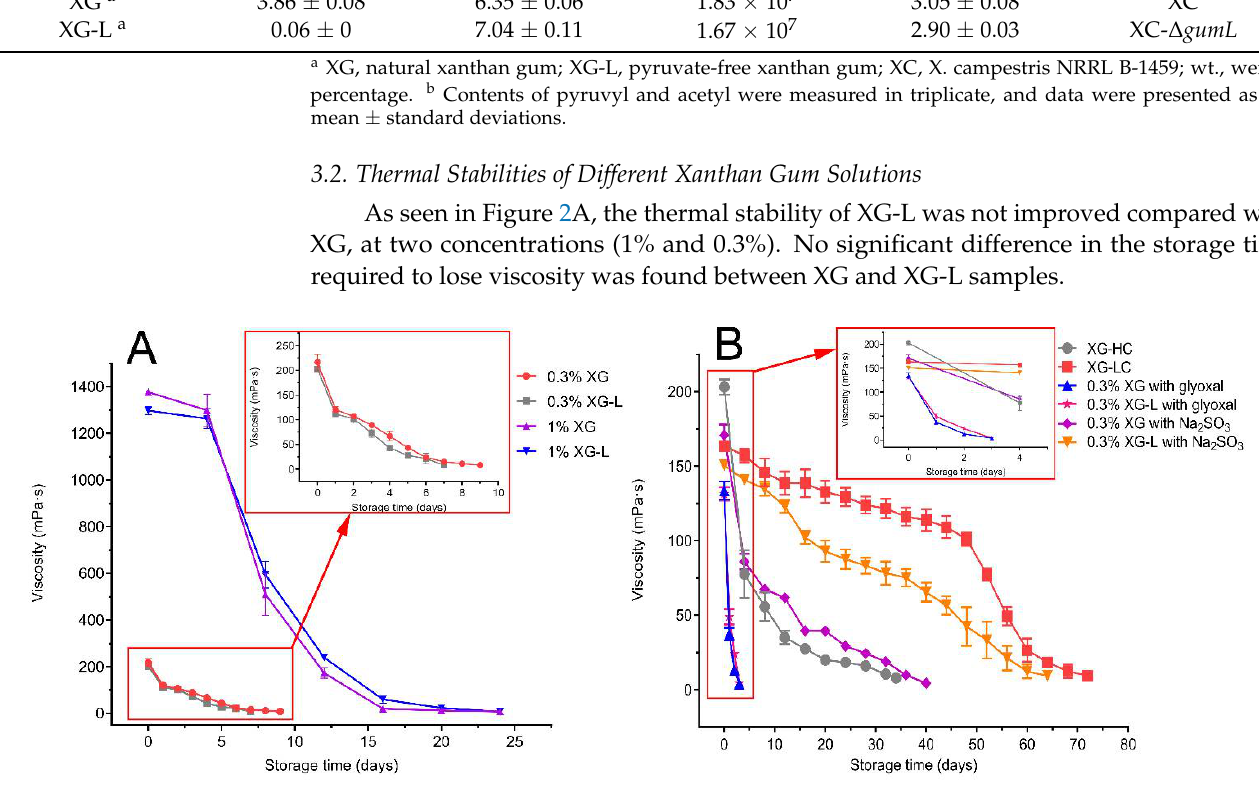
Figure 2. ( A ) Thermal stability of XG and XG-L at different concentrations; ( B ) Thermal stability of XG-HC, XG-LC, XG, and XG-L with Na 2 SO 3 or glyoxal. XG, natural xanthan gum; XG-L, pyruvate- free xanthan gum; XG-HC, natural xanthan gum with a deoxidizer and glyoxal added; XG-LC pyruvate-free xanthan gum with a deoxidizer and glyoxal added.